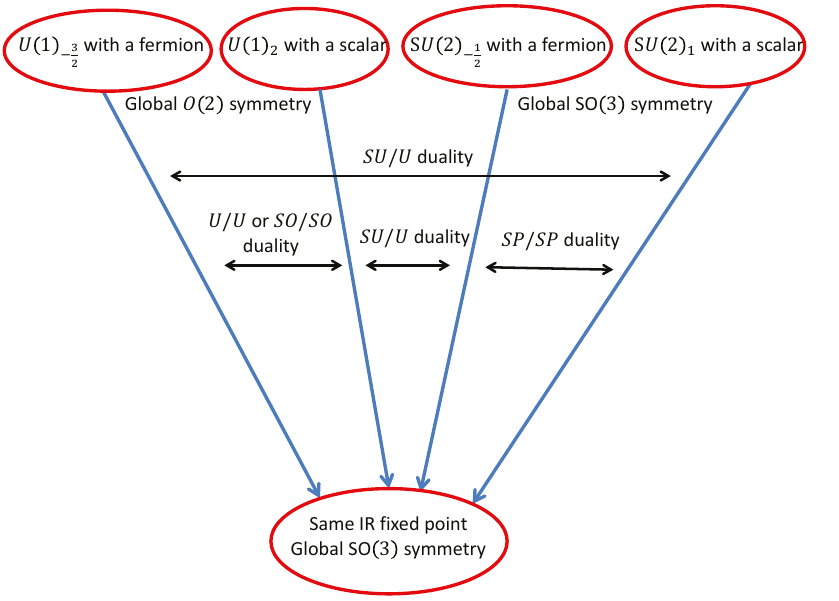
Figure 1 . Four UV theories, related by dualities, (cid:13)ow to the same IR (cid:12)xed point. The two UV theories with SU(2) gauge symmetry have a global SO(3) symmetry, and therefore the IR theory also has that global symmetry. The two UV theories with U(1) gauge symmetry have only O(2) global symmetry. The duality implies that they have an enhanced quantum SO(3) global symmetry in the